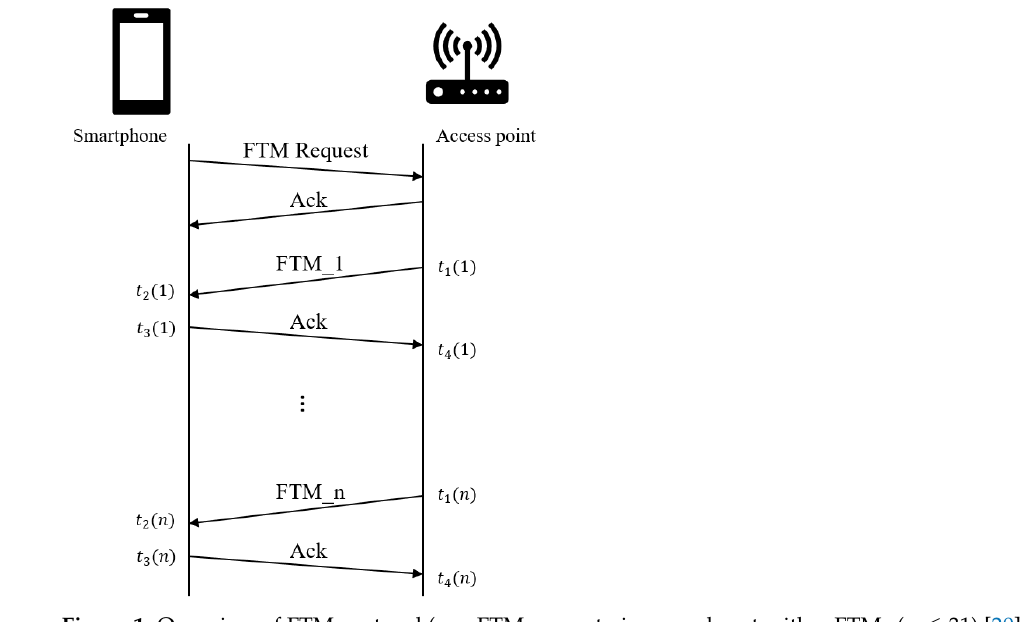
Figure 1. Overview of FTM protocol (one FTM request gives one burst with n FTMs ( n ≤ 31)